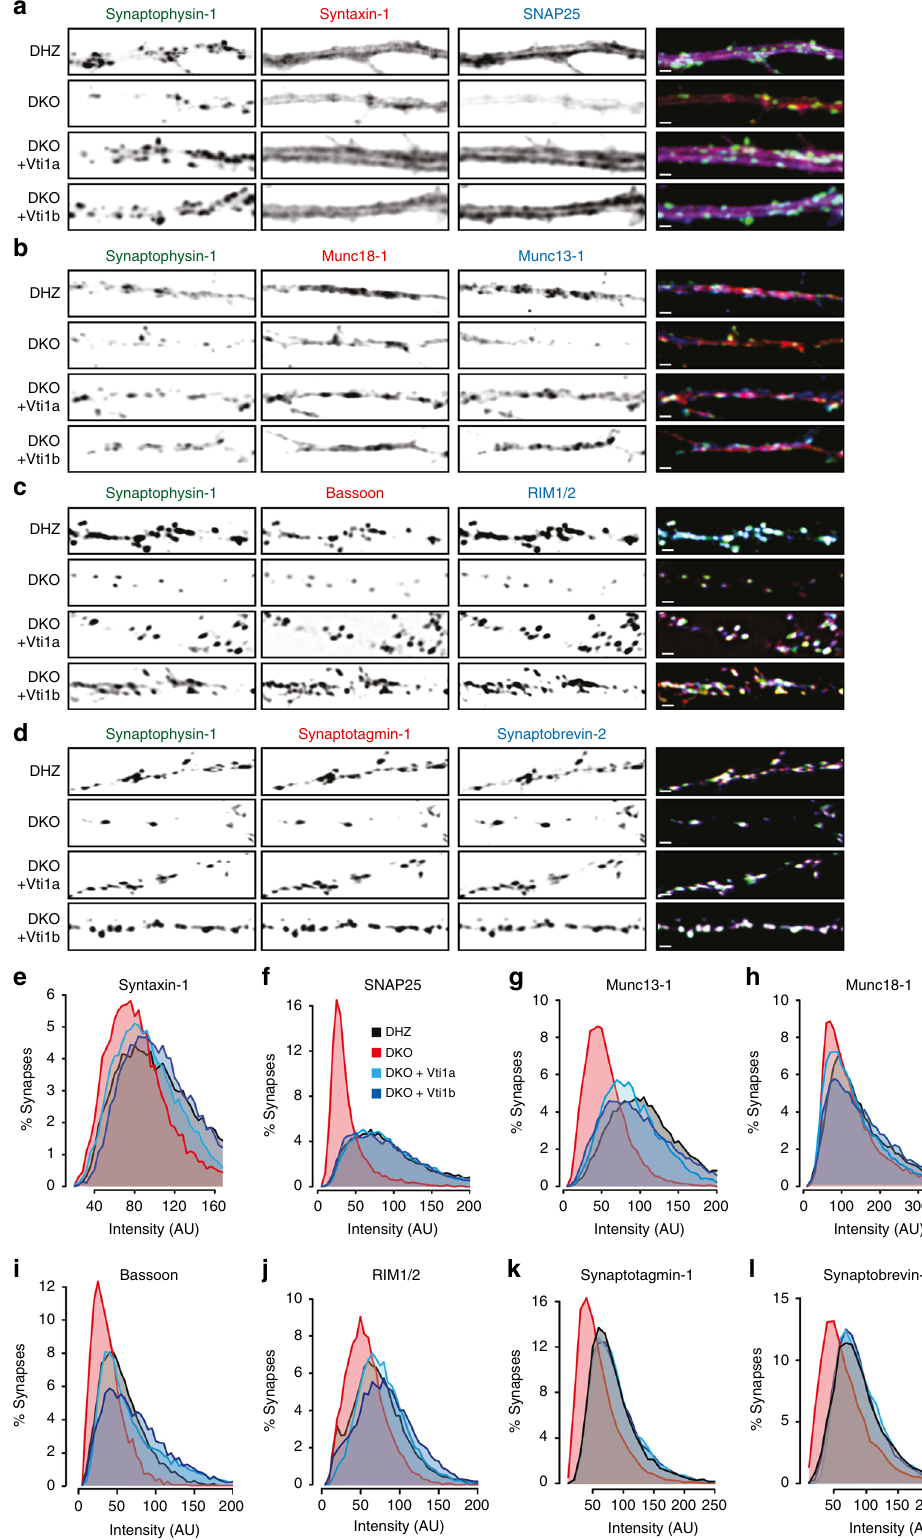
Fig. 4 Reduced synaptic levels of proteins that mediate secretion in Vti1a/b-de fi cient neurons. a – d Representative examples of single DIV-14 neurons immunostained for Synaptophysin-1 as synaptic marker and Syntaxin-1 and SNAP25 ( a ), Munc18-1 and Munc13-1 ( b ), RIM1/2 and Bassoon ( c ), and Synaptobrevin-2 and Synaptophysin-1 ( d ). e – l Intensity distribution of the levels of Syntaxin-1 ( e ), SNAP25 ( f ), Munc13-1 ( g ), Munc18-1 ( h ), Bassoon ( i ), RIM1/2 ( j ), Synaptotagmin-1 ( k ), Synaptobrevin-2 ( l ) in all synapses ( n = Over 15,000 synapses per protein and group). Statistical signi fi cance tested in Supplementary Figure 5. Scale bar = 2 µ